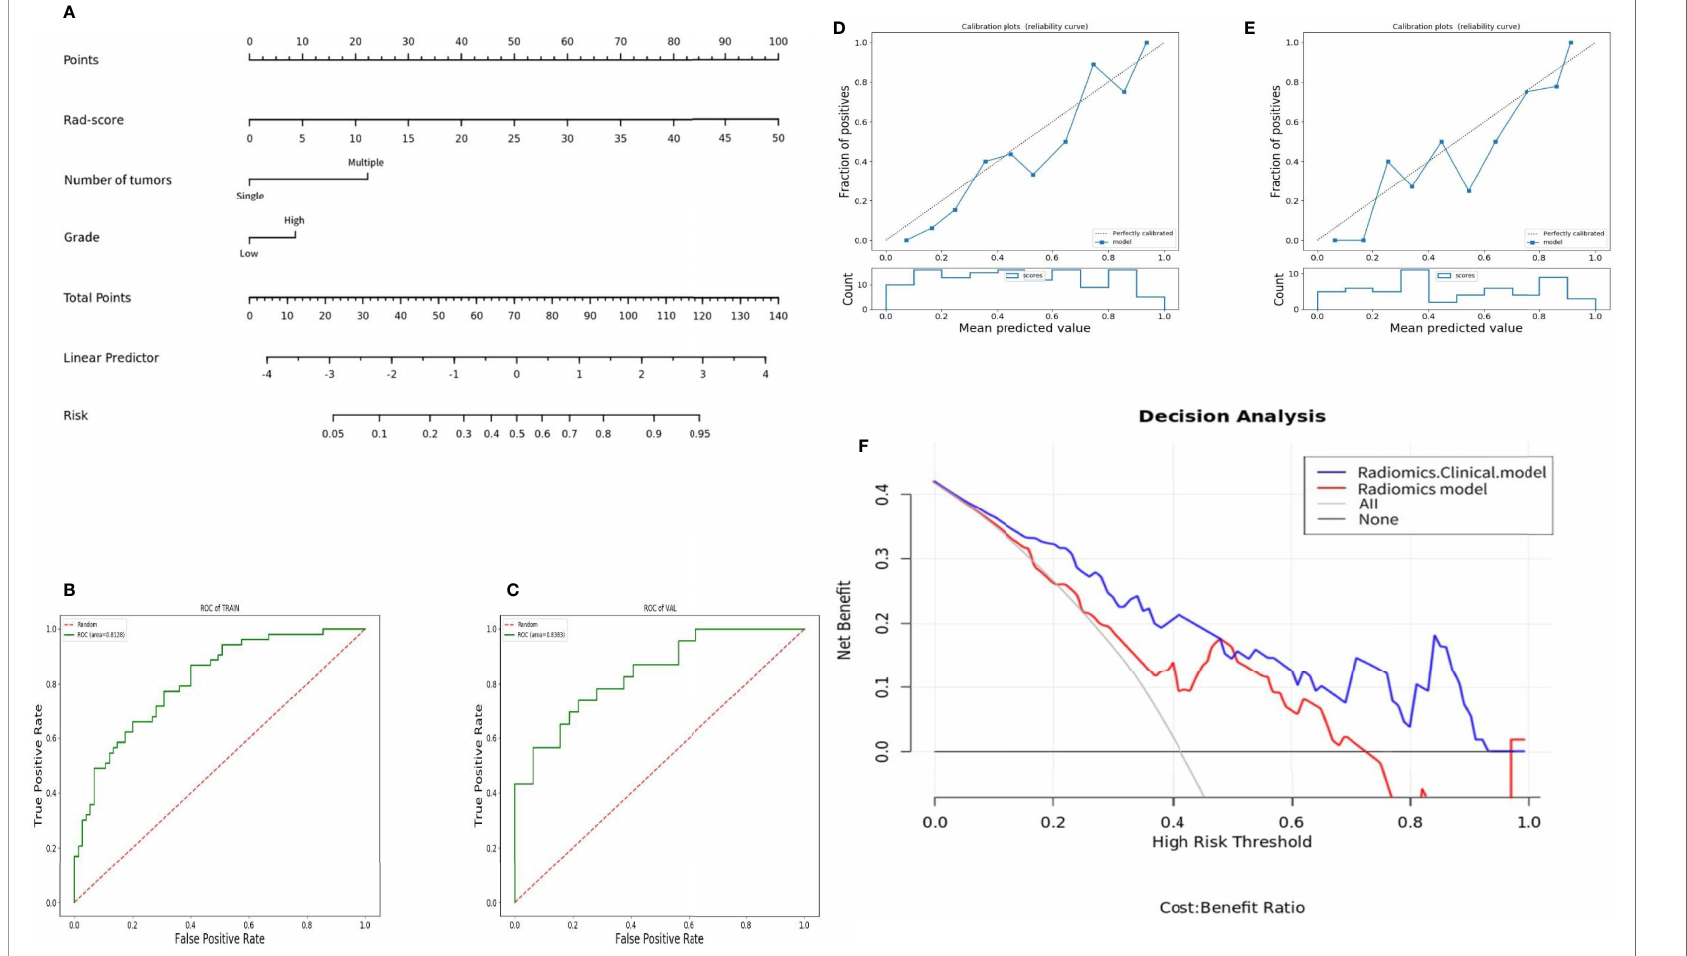
FIGURE 5 | Nomogram and its diagnostic performance: (A) Nomogram constructed based on patient number of tumors, tumor grade, and Rad-score; (B) and (C) are the ROC curves of the training group and the validation group of the radiomics-clinical model; (D) and (E) are the calibration curves of the nomogram of the training group and the validation group; (F) decision curve of the radiomics-clinical and radiomics model predicts the net income increment in recurrence risk of bladder cancer within 2 years after